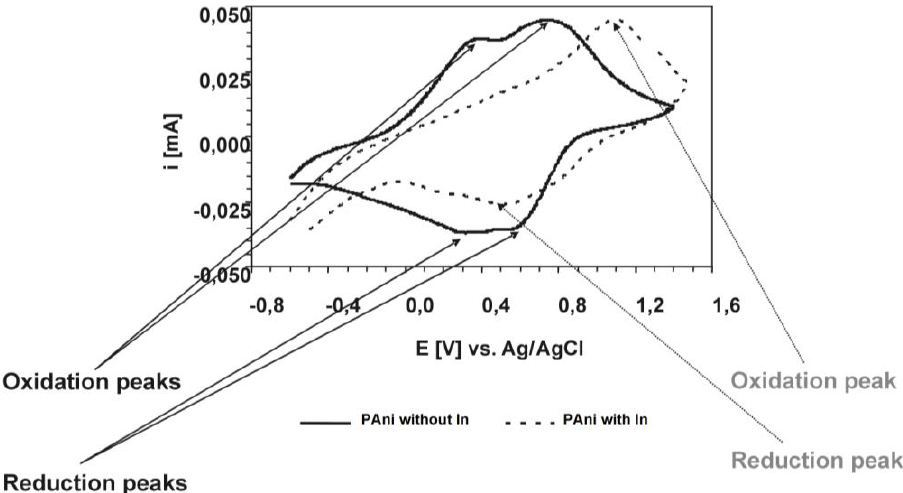
Figure 5. Cyclovoltammogram of Polyaniline dispersions with and without indium.